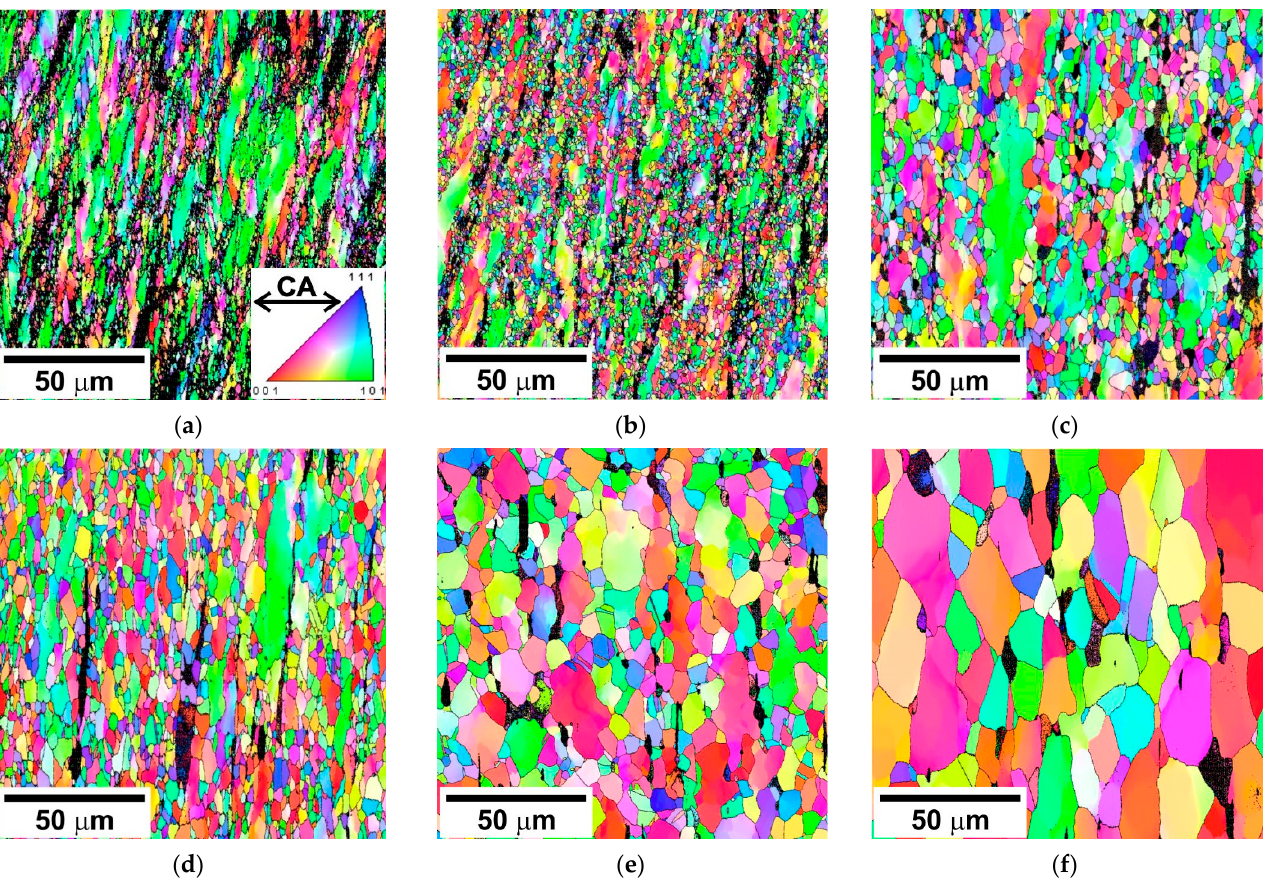
Figure 5. Typical OIM micrographs of a highly-alloyed austenitic stainless steel subjected to hot compression at 800 °C, 10 − 2 s − 1 ( a ) 900 °C, 10 − 2 s − 1 ( b ), 900 °C, 10 − 4 s − 1 ( c ), 1000 °C, 10 − 2 s − 1 ( d ), 1000 °C, 10 − 4 s − 1 ( e ), and 1100 °C 10 − 4 s − 1 ( f ). The colors indicate the direction along the compression axis (CA). The high-angle boundaries are indicated by black lines.